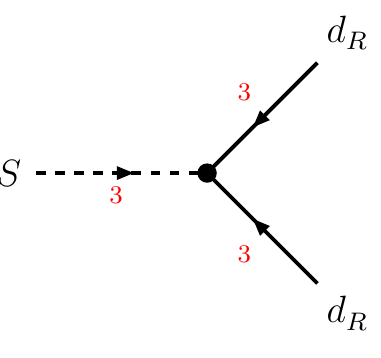
Figure 7 . An example of SU(3) C invariant vertex which is vanishing because of antisymmetric color